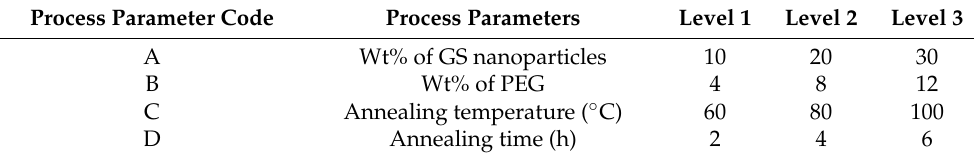
Table 11. Process parameters at different levels